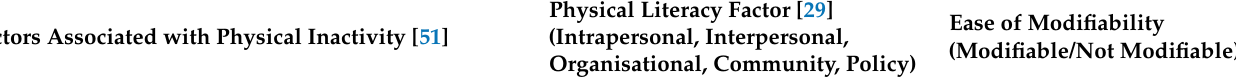
Table 2. Factors associated with physical inactivity and their potential